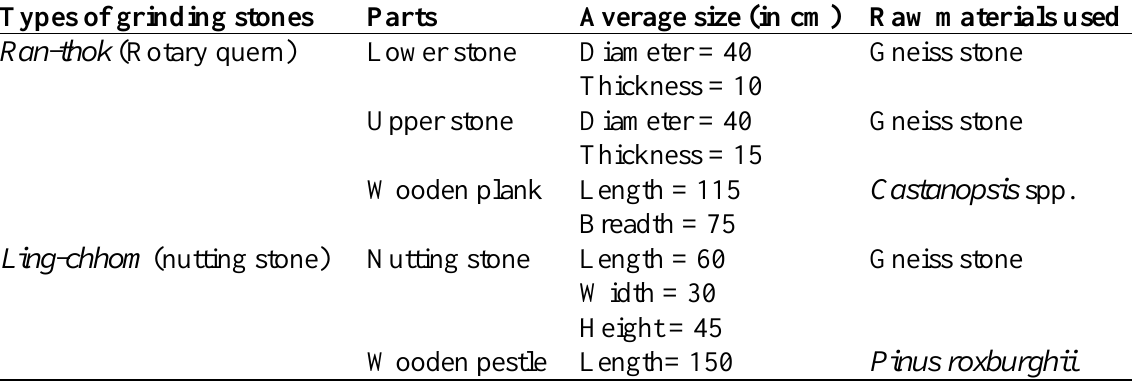
Table 1. Types of grinding tools, average size and raw materials